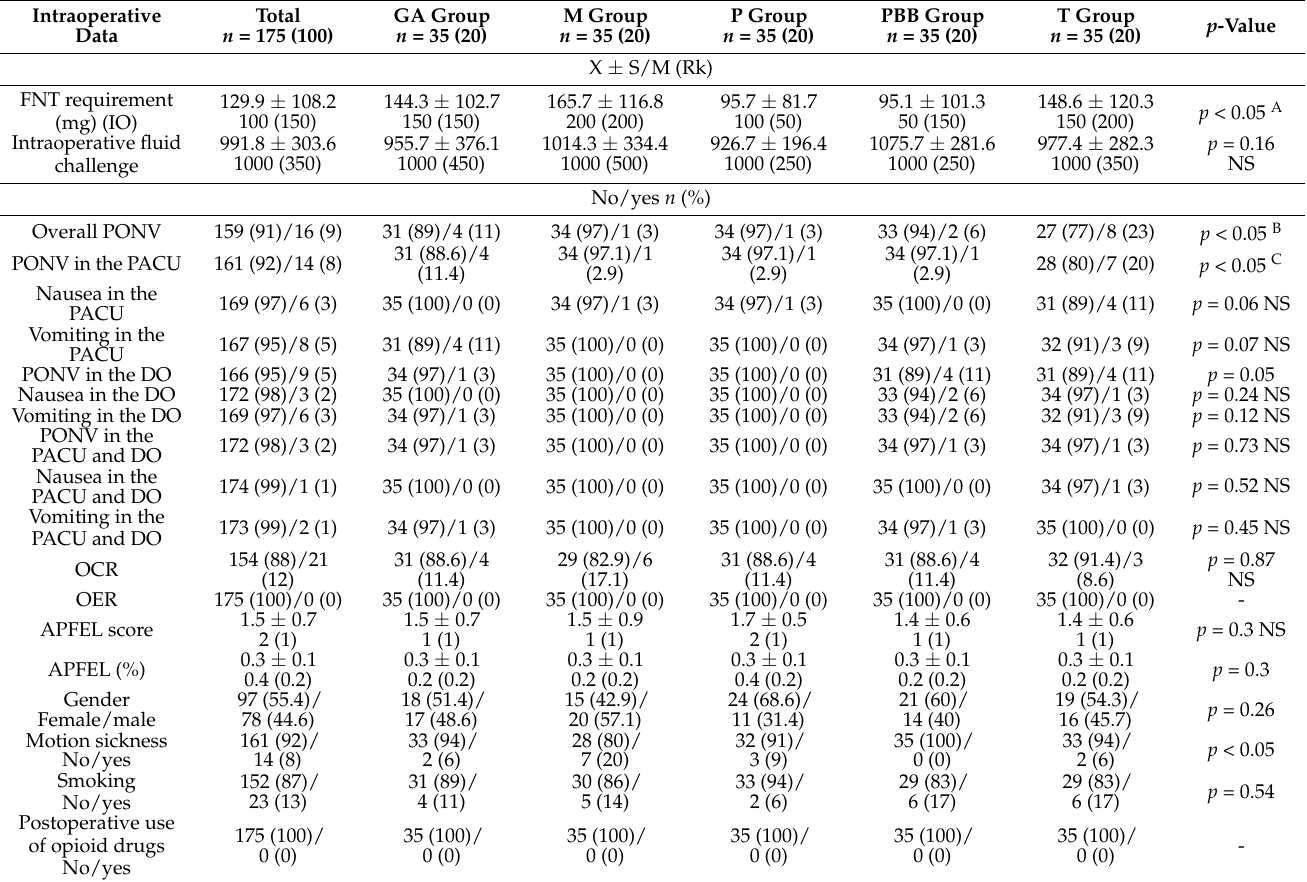
Table 1. Rate of PONV, OCR, and OER in patients regarding group